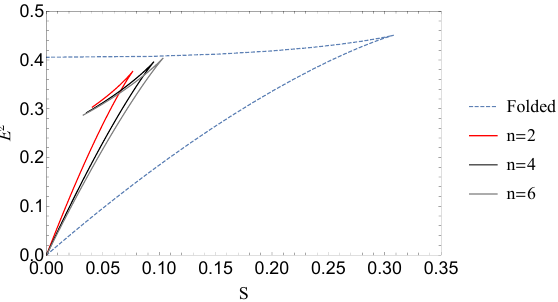
Figure 13 . Regge trajectories of inward spike solutions for N = 1 . The spin S and the energy E are plotted in the units of R 2 /α 0 and R/α 0 , respectively. For comparison, we illustrate the Regge trajectory of the one-folded string by the dotted blue